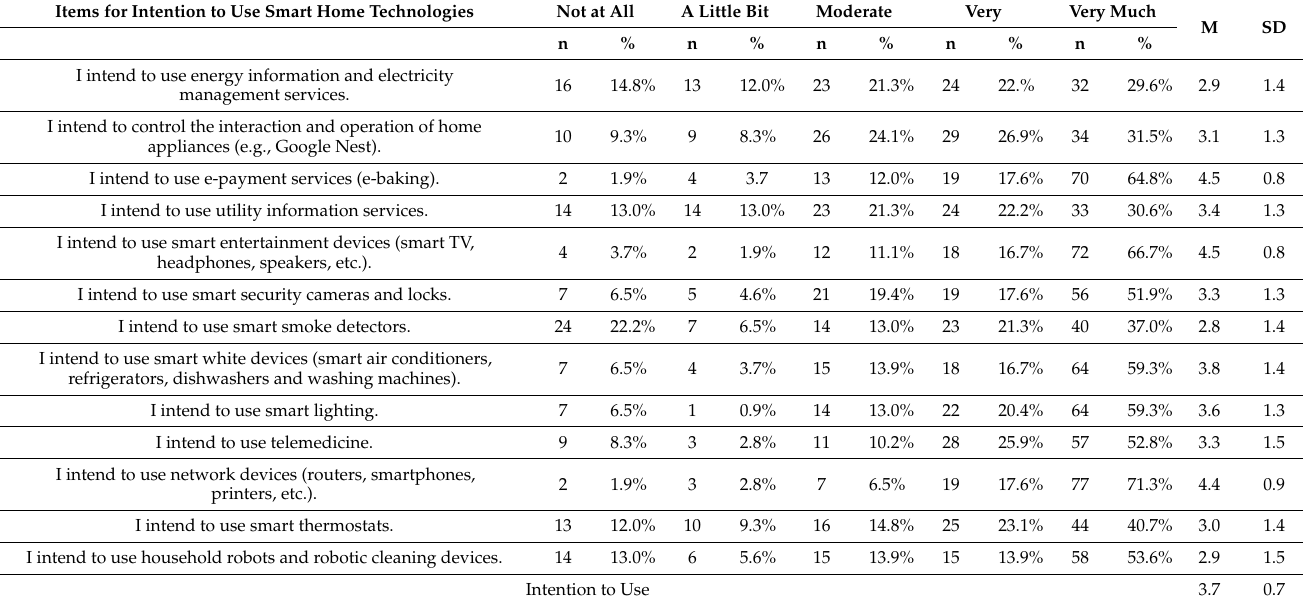
Table A8. Intention to use smart home